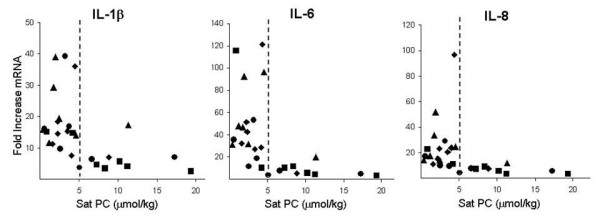
Relationship of pro-inflammatory cytokine mRNA and Sat PC in BALF. Scatter plots for cytokines based on Sat PC levels in BALF of individual lambs show decreased injury in lambs with Sat PC level > 5 μmol/kg. Cytokine mRNA levels were determined by RNase protection assays with L32 as an internal loading control. Values are expressed as fold increase of mRNA over unventilated controls, whose level was set to equal 1. ◆ No inhibitor ■ IL-1 inhibitor, ▲ NF-κB inhibitor ● IL-8 inhibitor.